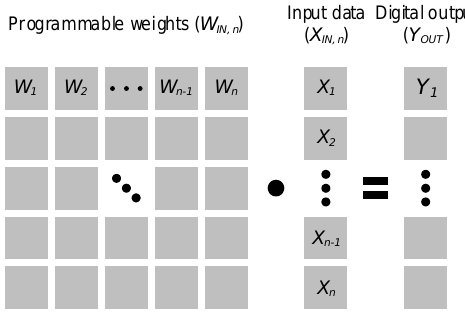
Figure 3. Vector-by-matrix multiplication.